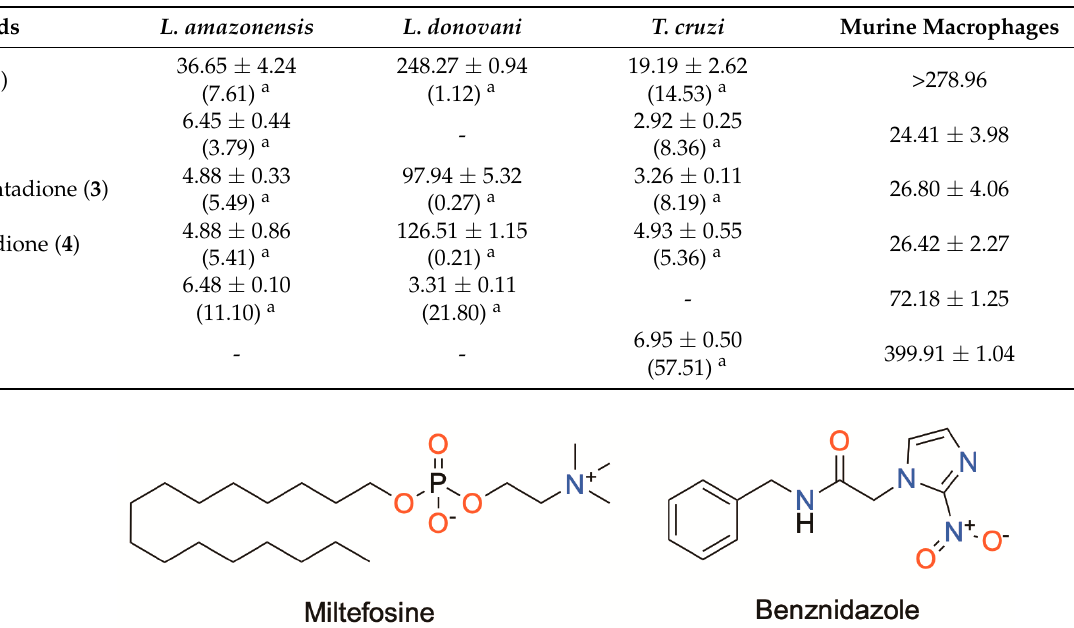
Figure 2. Chemical structures of the reference drugs, miltefosine and benznidazole.